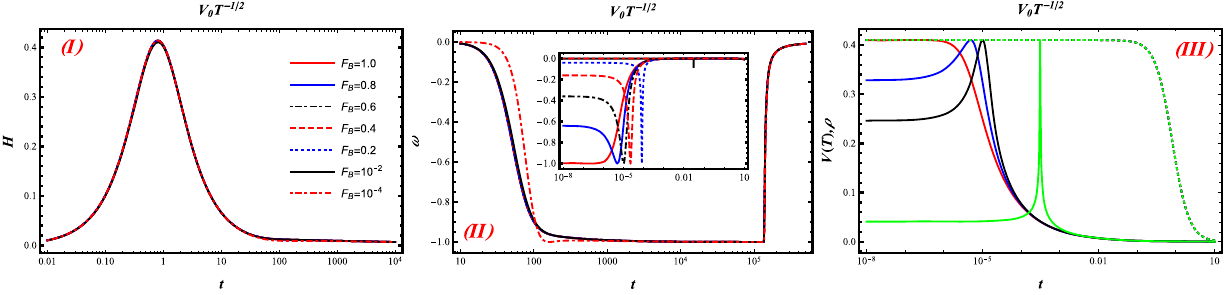
Fig. 3 Evolutions of H , ω , V ( T ) and ρ for different initial conditions for an inverse-power potential with n = − 1 / 2. The initial conditions for plots I and II are shown in II. Plot III is of V ( T ) (solid) and ρ (dotted) for the initial conditions F B = 1 (red), F B = 0 . 8 (blue), F B = 0 . 6 (black), and F B = 0 . 1